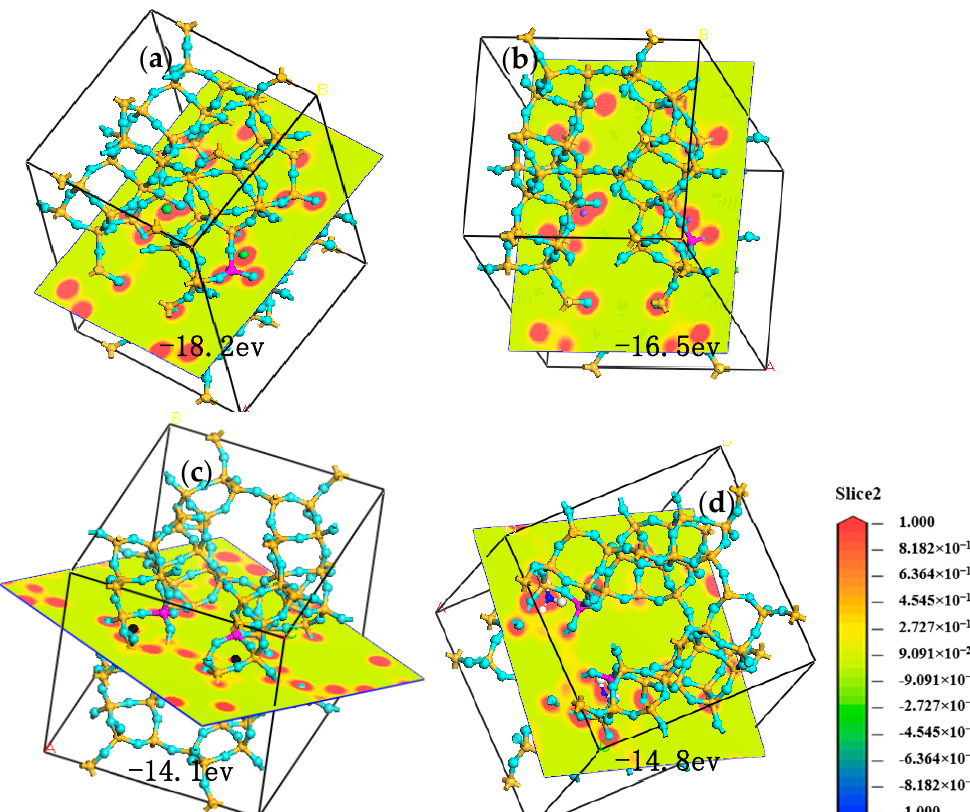
Figure 9. Molecular dynamic simulation of K-Cp ( a ), Li-Cp ( b ), Ca-Cp ( c ), and NH 4 -Cp ( d ). For all species, O = light blue, H = white, Si = yellow, Al = deep powder, K = green, Li = purple, and Ca = black and N = blue.